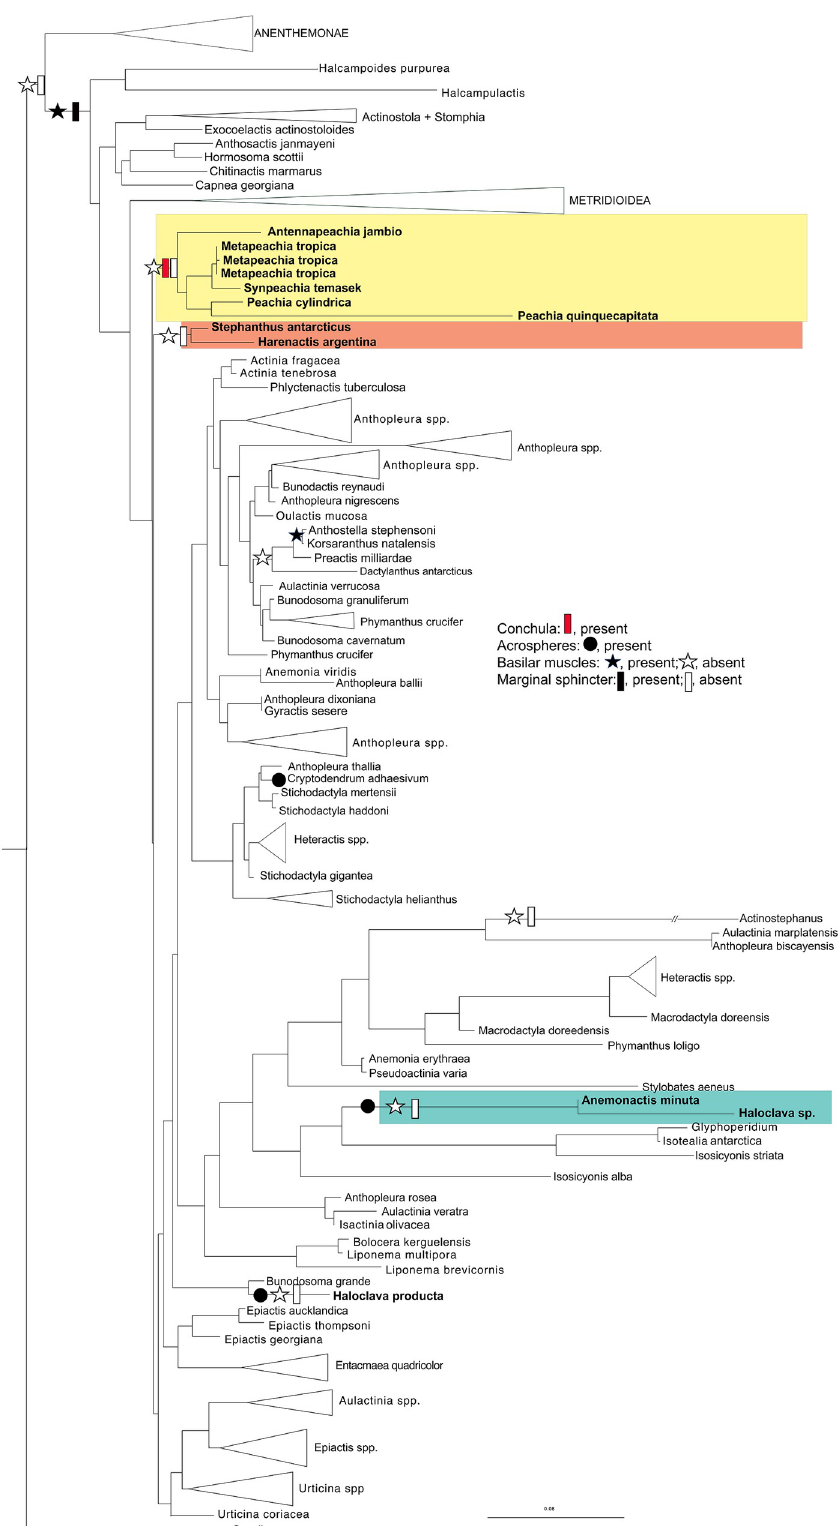
Fig 2. Ancestral state reconstruction of morphological characters. Representation of ancestral character state reconstruction for four morphological characters (conchula, acrospheres, basilar muscles, and marginal sphincter).